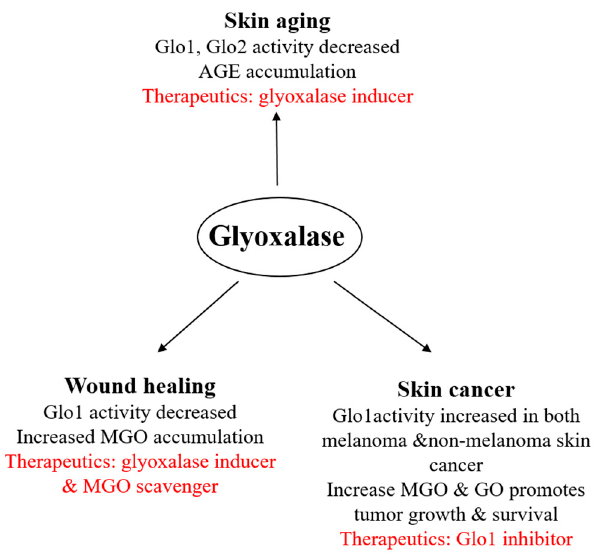
Figure 2. Schematic representation of the glyoxalase system in skin aging, skin cancer and other skin abnormalities. Glyoxalase activity (Glo1 and Glo2) is reduced in skin aging and age-related wound healing with the accumulation of MGO, GO and AGE, while Glo1 activity is highly expressed in both melanoma and non-melanoma skin cancer. With the increase in Glo1, intracellular MGO and GO are detoxified, promoting tumor growth and survival. Glyoxalase regulators are potential therapeutic agents to reduce skin abnormalities. The role of glyoxalase in other skin abnormalities such as hyperpigmentation, psoriasis, vitiligo, AD etc., and Glo2 in skin cancer, has not yet been investigated. Glo1, glyoxalase I; Glo2, glyoxalase II, MGO, methylglyoxal; GO, glyoxal, AD, atopic dermatitis.